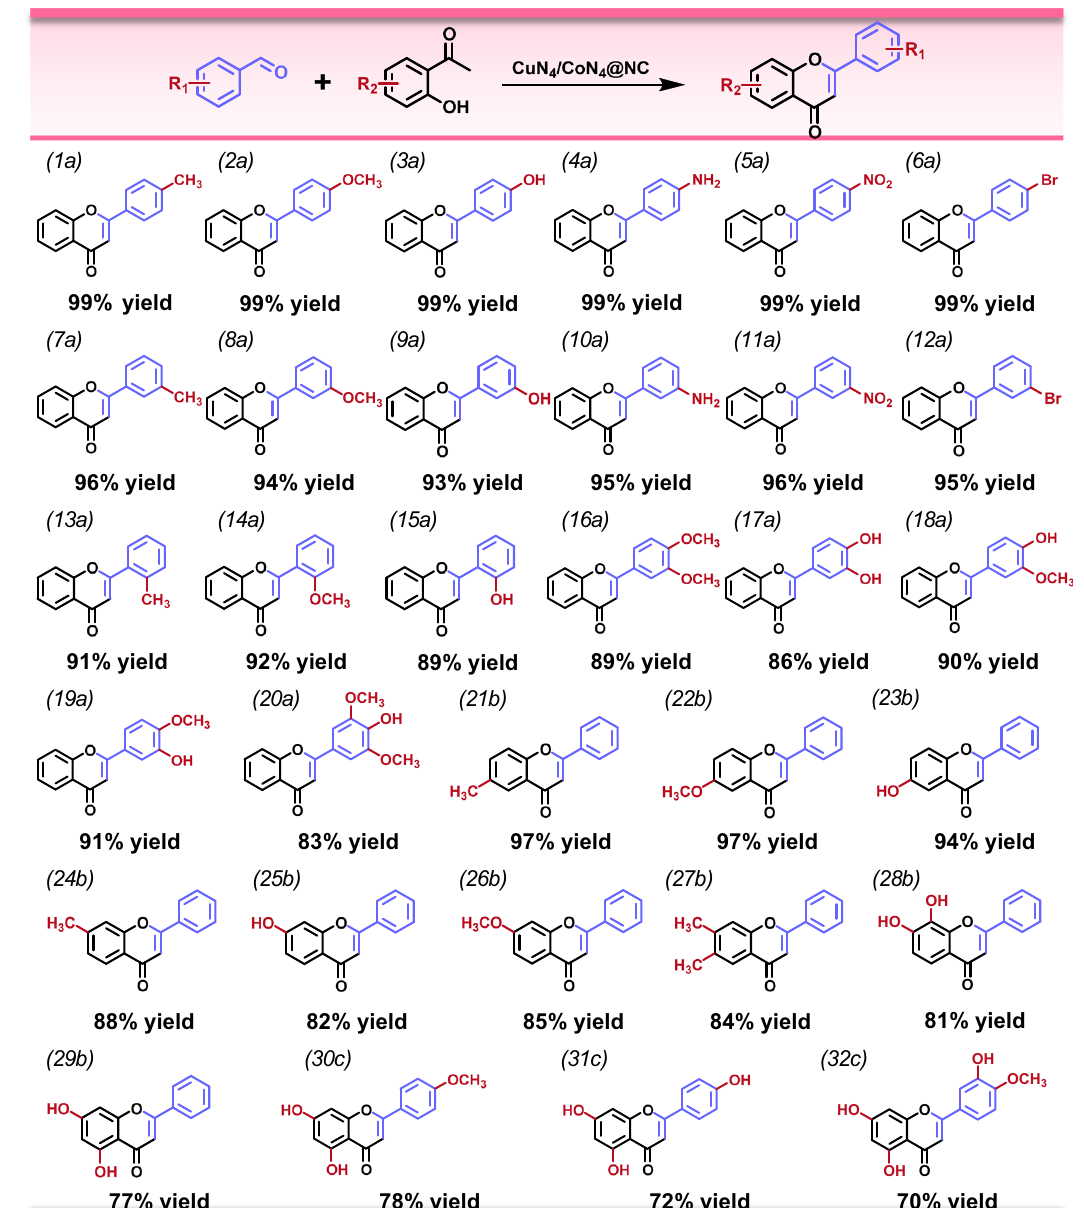
Fig. 5| Scopeofthedominoreactiontovarious fl avones. Reactionconditions:aldehyde (1mmol), ketone (1.5mmol),catalyst(totalmetal, 1.4mol%), n -hexanol(4mL), O 2 (2bar), 140°C, 12h. Conversion and yield were determined by GC-MS based on